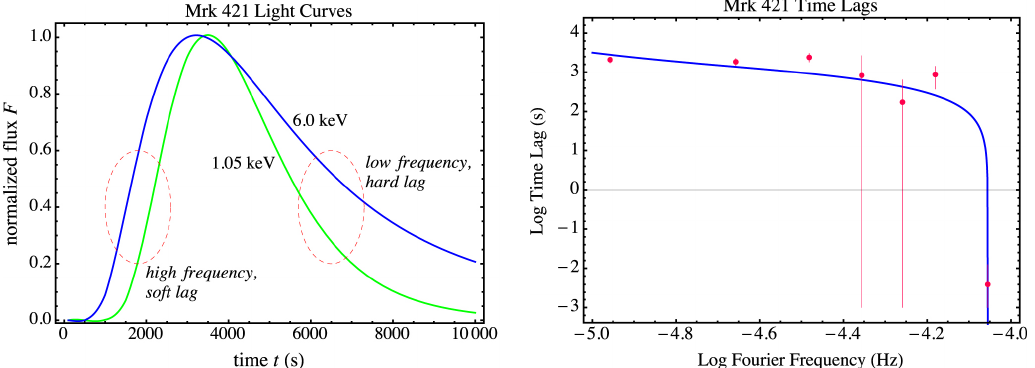
Figure 16. Left : Re-constructed X-ray light curves at 1.05 and 6 keV from a Fourier-space solution to time-dependent electron acceleration and synchrotron emission in Mrk 421. Right : The resulting Fourier-frequency-dependent time lags, compared to Beppo SAX data from [154]. From